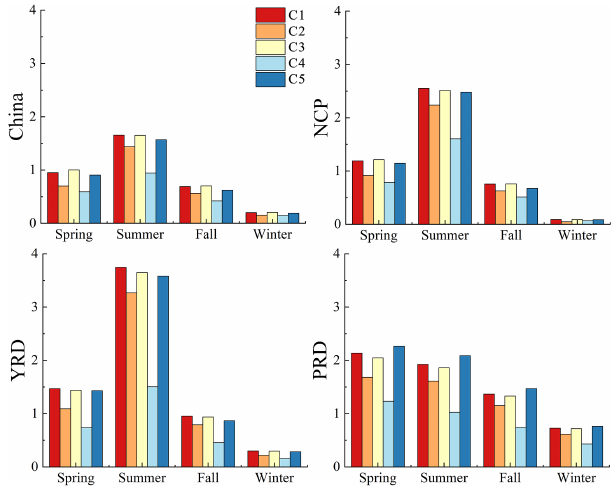
Figure 9. Seasonal distributions of biogenic SOA (BSOA) for all cases in important regions and China. Unit is micrograms per cubic meter of